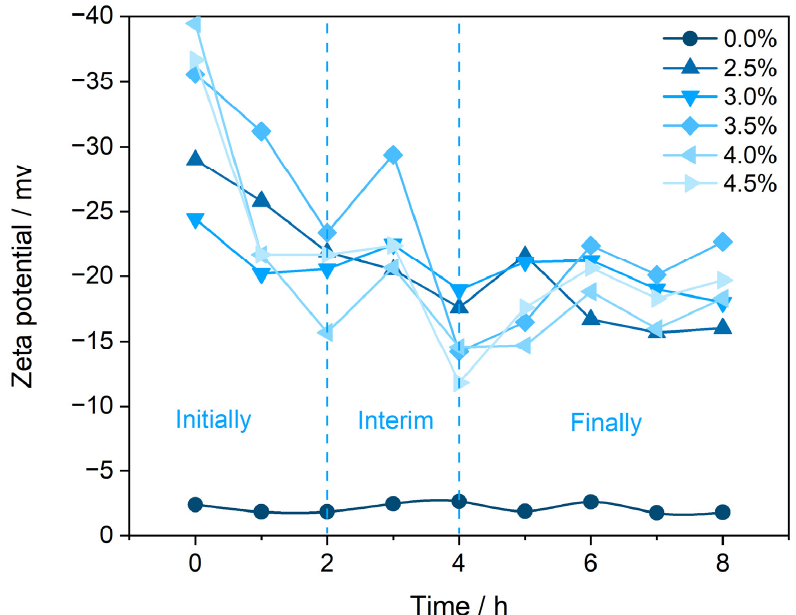
Figure 4. Effect of the concentration of leaching agent on Zeta potential of rare earth particles during the leaching process. Preparing magnesium sulfate solutions with pH 2, 3, 4, 5, 6 and mass concentration of 3.5% for column leaching experiment. As presented in Figure 5, when magnesium sulfate solutions with different pH are used for leaching, the absolute value of Zeta po- tential on the surface of rare earth particles decreases with the leaching time going on.